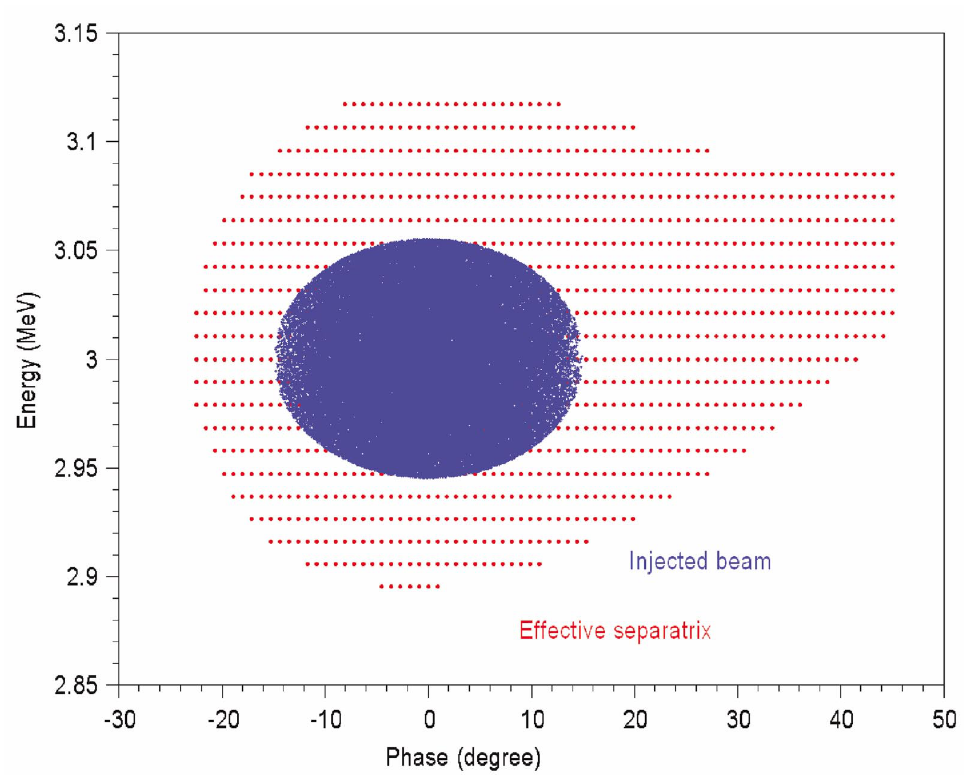
FIG. 25. (Color) Separatrix and initial